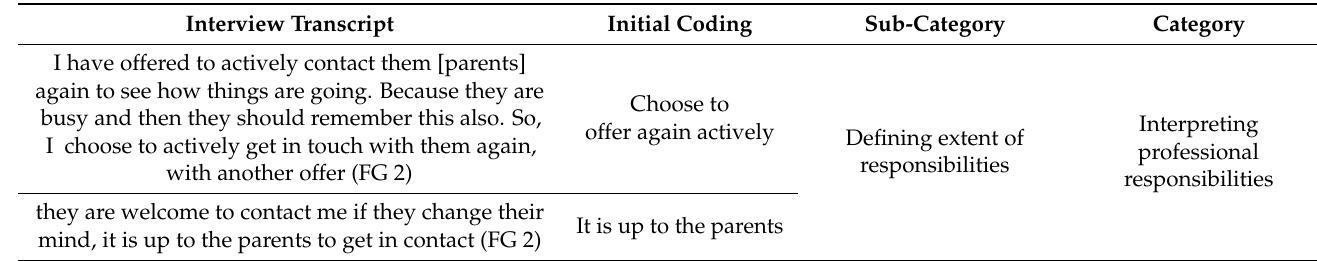
Table 1. Example of data analysis.